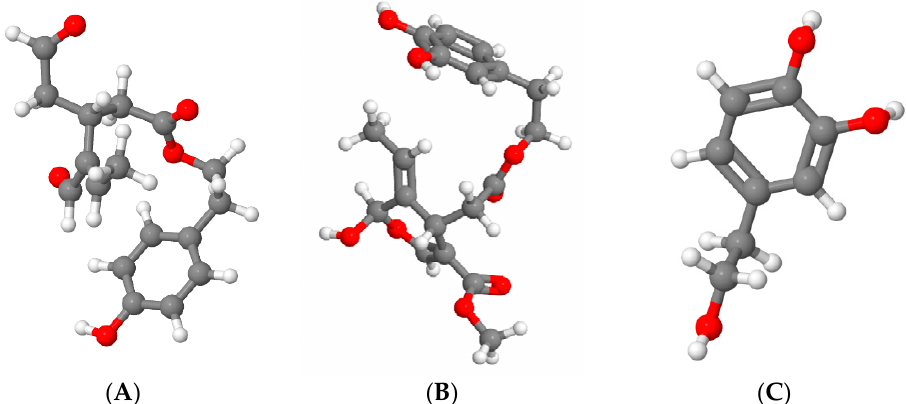
Figure 3. Chemical structures of ( A ) p-HPEA-EDA, ( B ) 3,4-DHPEA-EA, and ( C ) hydroxytyrosol. The images were ob- tained with Jmol viewer